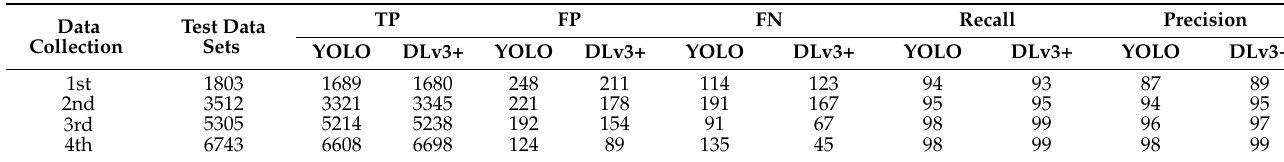
Table 7. Cultivated land search results for B2.